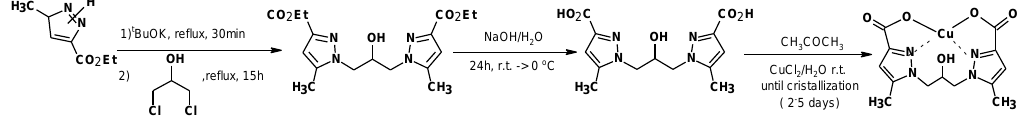
Figure 12. Synthesis of the copper complexes CuL1.